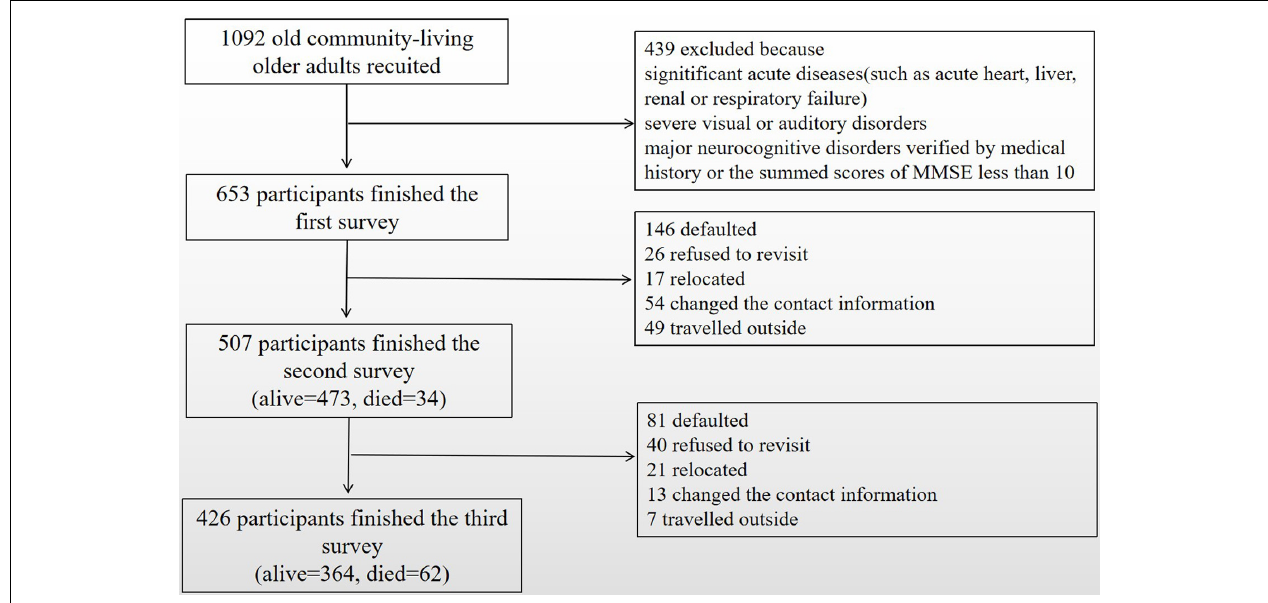
FIGURE 1 | Flowchart of the